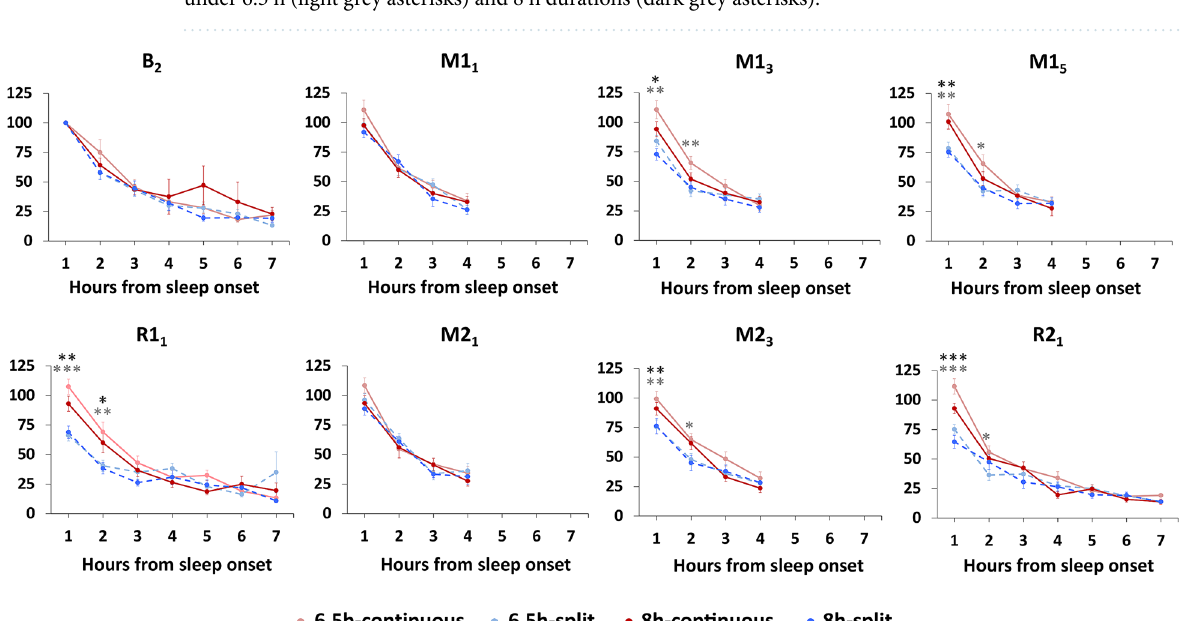
Figure 5. Homeostatic sleep pressure. Sleep pressure is indicated by several metrics by comparing baseline (B 2 ) to the final day of the first manipulation week (M1 5 ). ( a ) A decrease in nocturnal N2 latency from baseline suggests a relative increase of sleep pressure over the manipulation week. That is, participants fall asleep faster if they have higher sleep pressure. N2 latency showed a similar increase of sleep pressure across groups, except for the 8 h-split group who showed little change. This suggests that splitting sleep for the 8 h duration led to a relative decrease in the amount of homeostatic sleep pressure. ( b ) Sleep efficiency tends to increase as sleep pressure increases, because participants fall asleep faster and are less likely to wake during the night. Sleep efficiency remained at baseline levels for both split sleep groups, but was significantly increased for continuous sleep groups. Again this suggests relatively lower sleep pressure under the split sleep schedule (Table 2 for main effects). ( c ) Slow-wave energy (SWE) in the first hour of nocturnal sleep (H1) provides an indication of sleep pressure accumulated during the day. SWE remained at baseline levels for the continuous sleep groups, while it significantly decreased for both split sleep groups, suggesting reduced sleep pressure under the split sleep schedule. Mean ± SEM. ***p < 0.001, **p < 0.01, *p < 0.05 for contrasts between split and continuous groups under 6.5 h (light grey asterisks) and 8 h durations (dark grey asterisks).